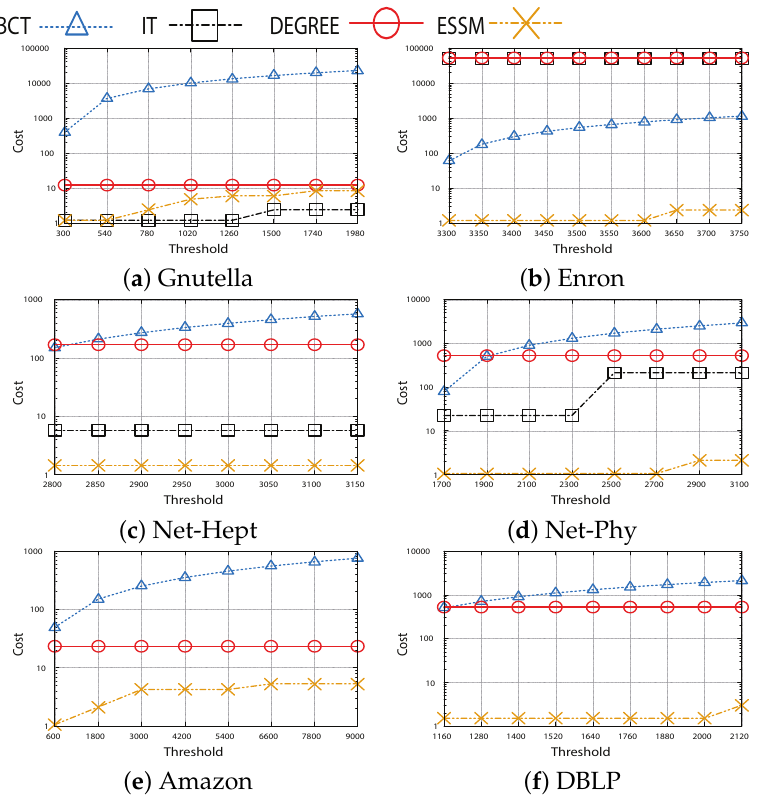
Figure 1. Comparison about Costs of seed sets between ESSM and other algorithms with threshold Ti from 300 to